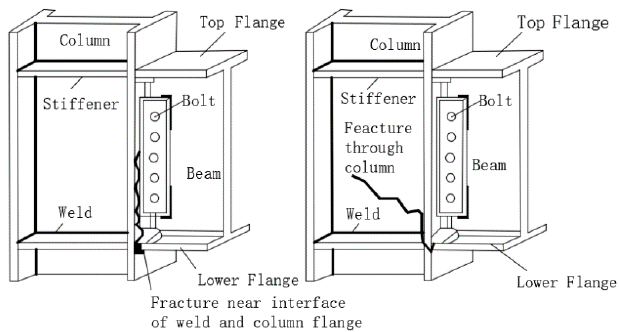
Figure 1. The brittle failure of a rigid connection in the Northridge earthquake.